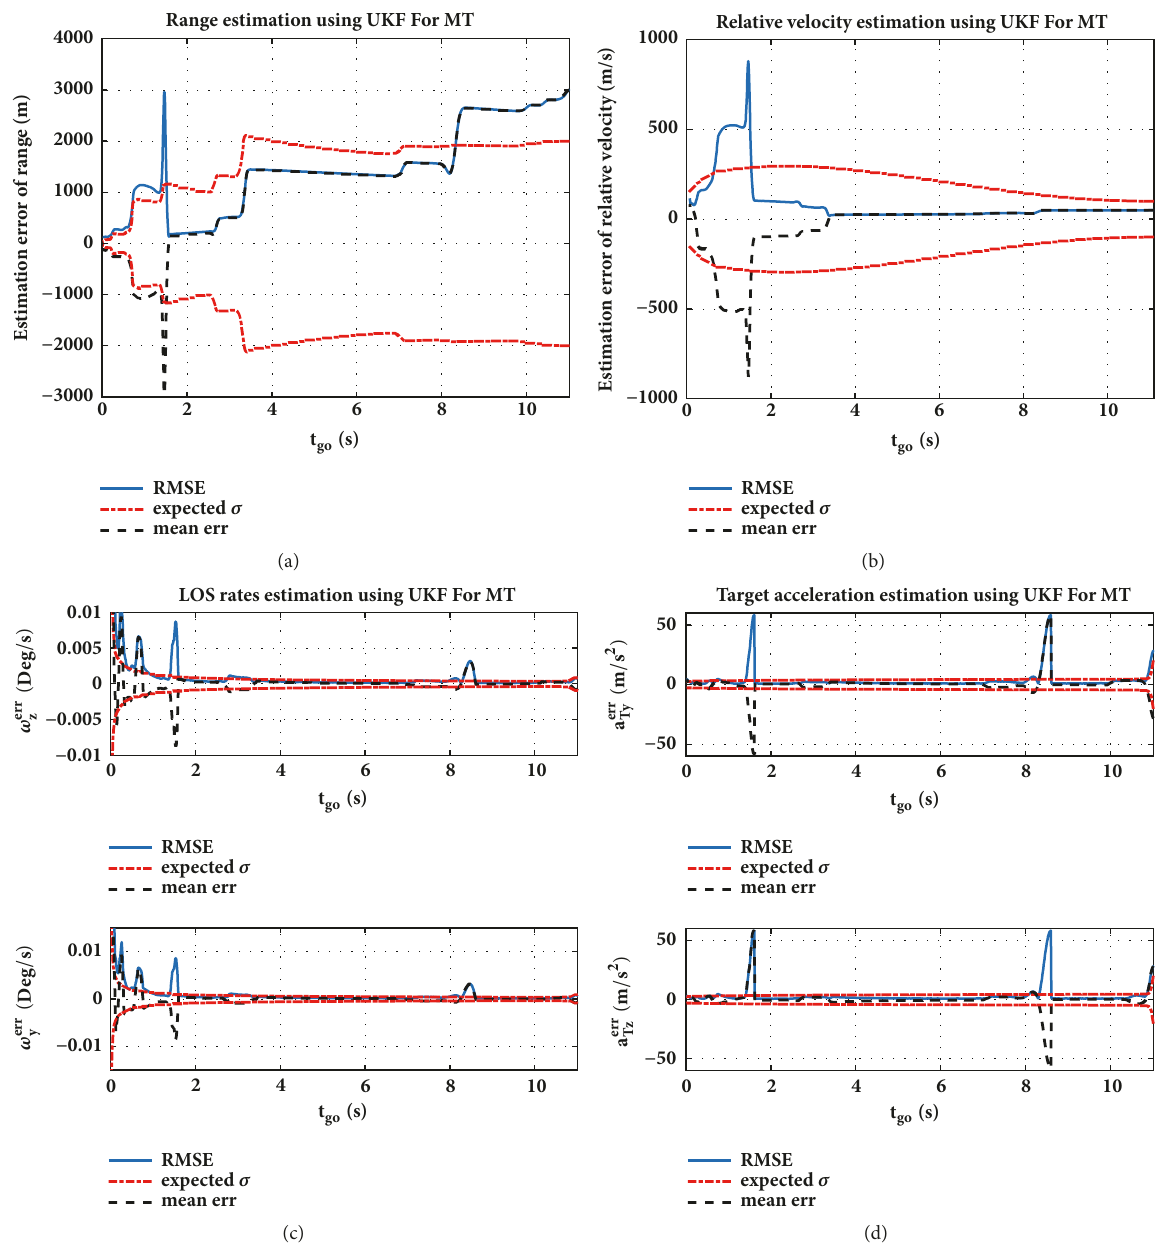
Figure 13: (a) Range estimation errors using UKF for MT. (b) Relative velocity estimation errors using UKF for MT. (c) LOS rates estimation errors using UKF for MT. (d) Target acceleration estimation errors using UKF for